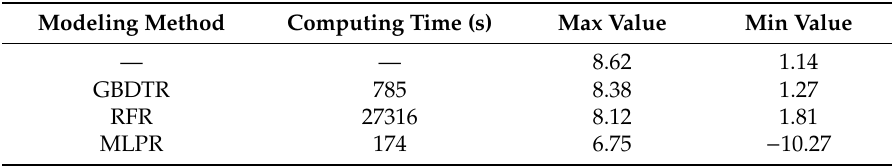
Figure 13. Spatial distribution of the Nemerow index based on the di ff erent models in the Xunsi River dataset: ( a ) GBDTR, ( b ) RFR, ( c ) MLPR. Table 5. Statistical information of the UAV-borne image inversion based on the di ff erent models in the Xunsi River